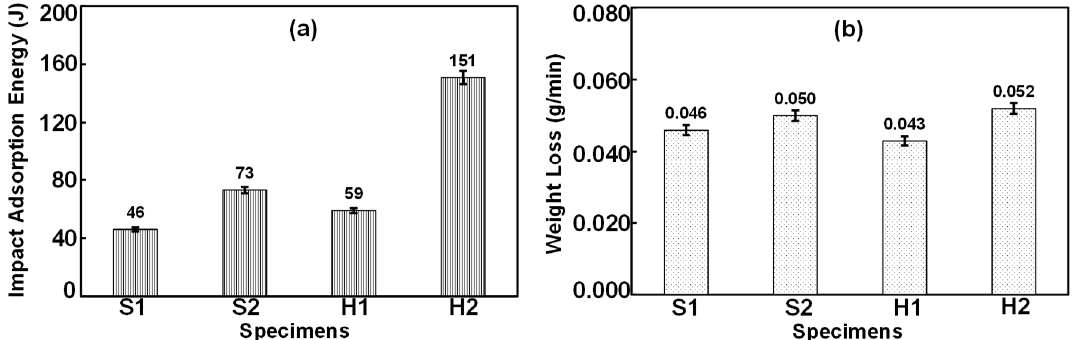
Figure 9. The testing results of welded specimens: ( a ) impact and ( b ) abrasive wear.